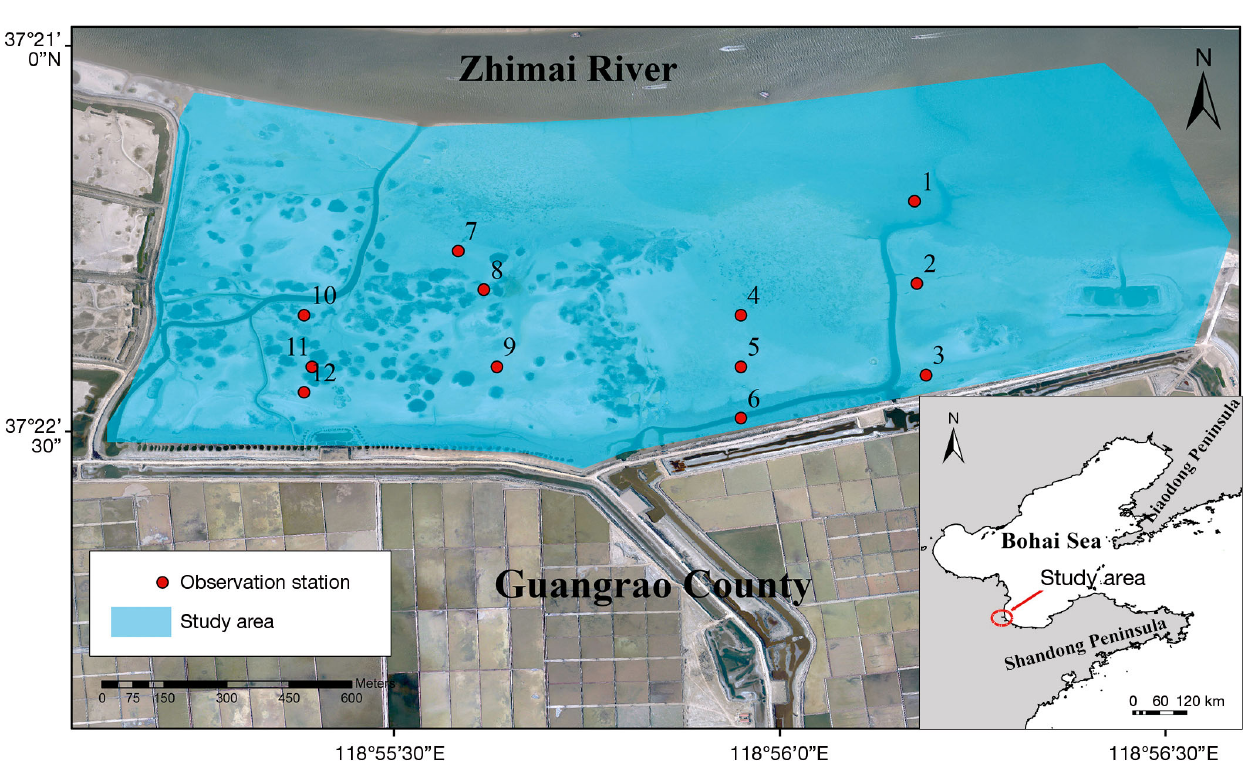
Fig. 1. Study area and monitoring stations in the estuarine wetlands of the Zhimai River, Laizhou Bay, northern